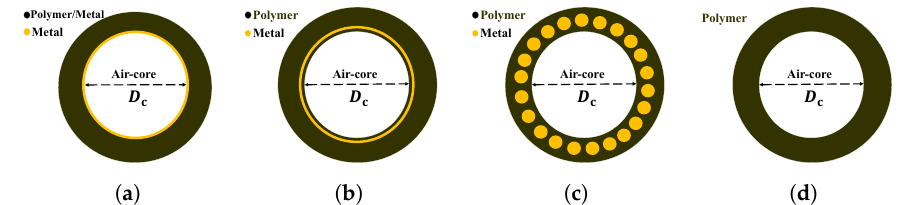
Figure 1. Simple schematic diagram with ( a ) metal HWG: Fiber geometry based on the design presented in [18]; ( b , c ) hybrid cladded metal HWG: Fiber geometry based on the design presented in [30–33]; ( d ) polymer HWG: Fiber geometry based on the design presented in [22]. The color of each design indicates the materials as metal film/wires (yellow), polymer (black), and air (white),